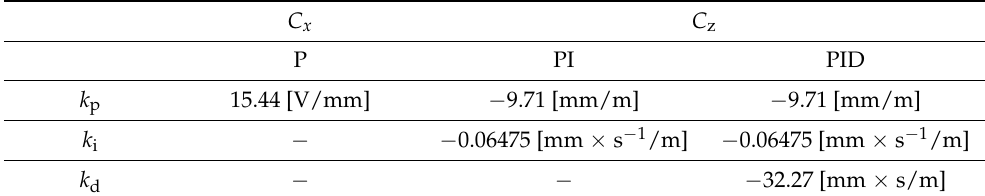
Table 1. Controller parameters used in experimental trials.